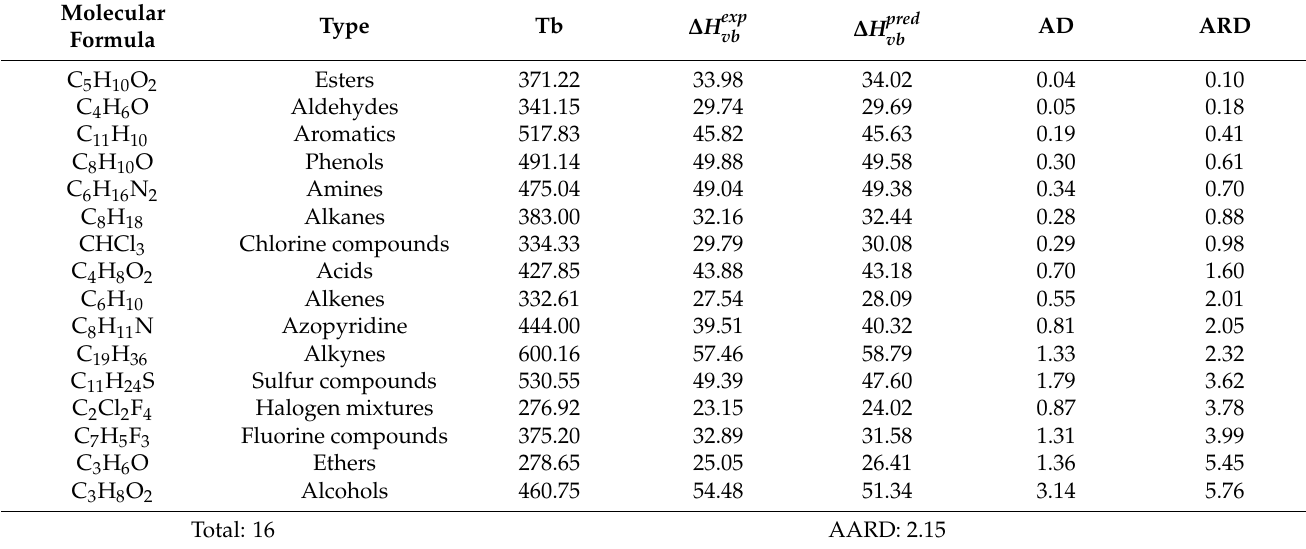
Table 3. Average relative error in estimating organic compound evaporation